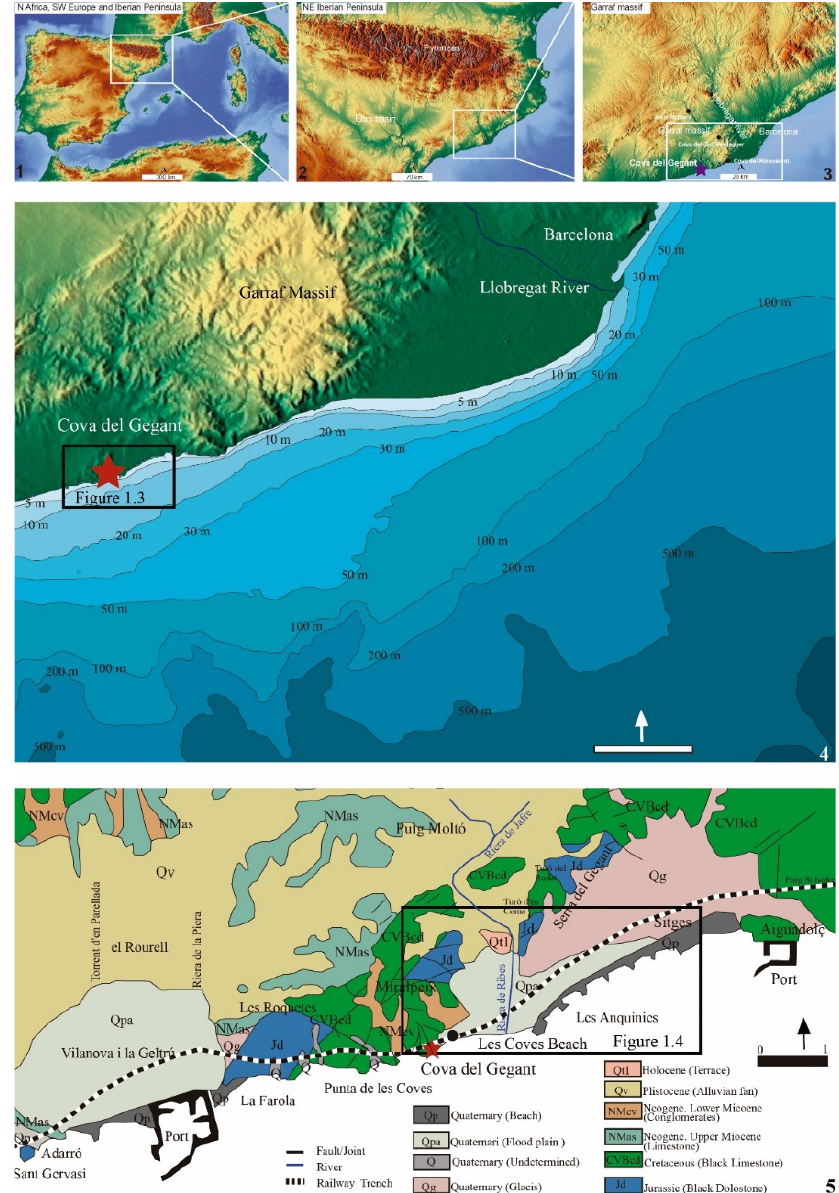
Figure 1. Regional context of Cova del Gegant. ( 1 – 3 ): Location of the archaeological site. The